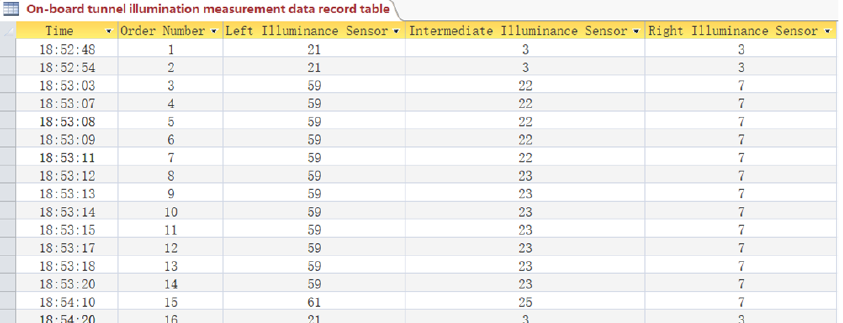
Figure 11. Access database interface at 18:00.